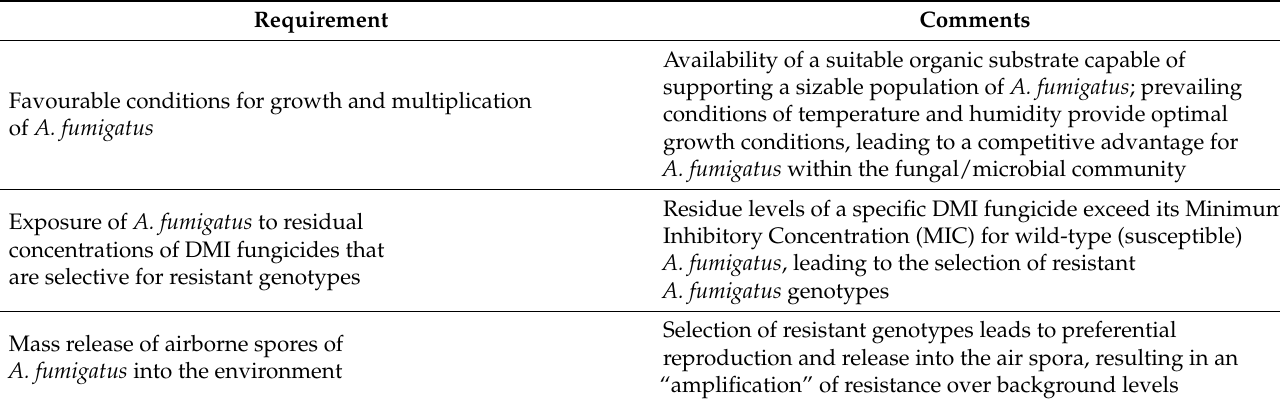
Table 1. List of requirements for classifying an agronomic setting as a hotspot for the amplification of DMI fungicide resistance in Aspergillus fumigatus